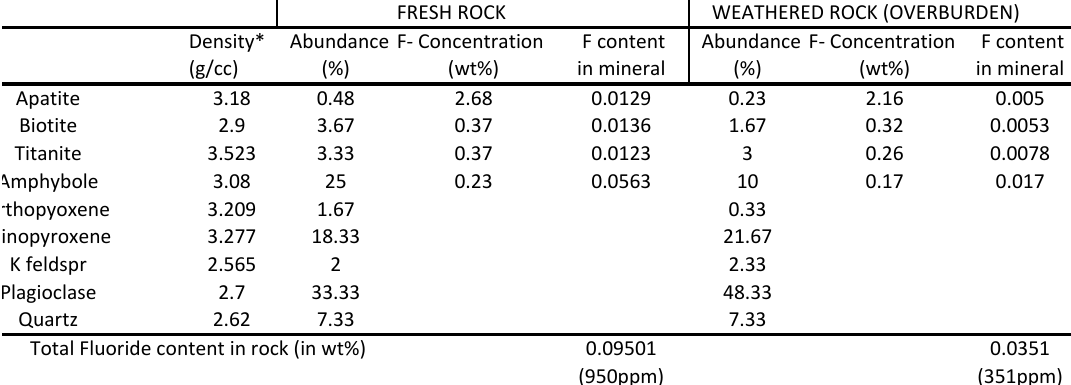
Fluoride budget